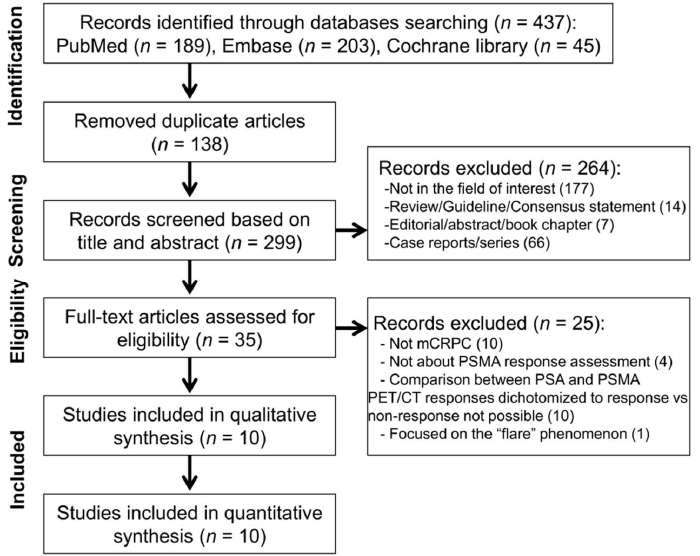
Figure 1. PRISMA flow chart showing the study selection process. CRPC = castration-resistant prostate cancer